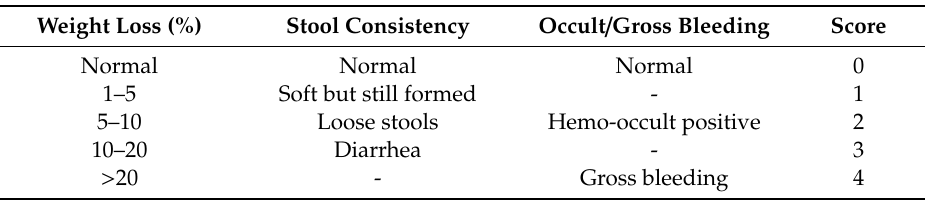
Table 4. Scoring of disease activity